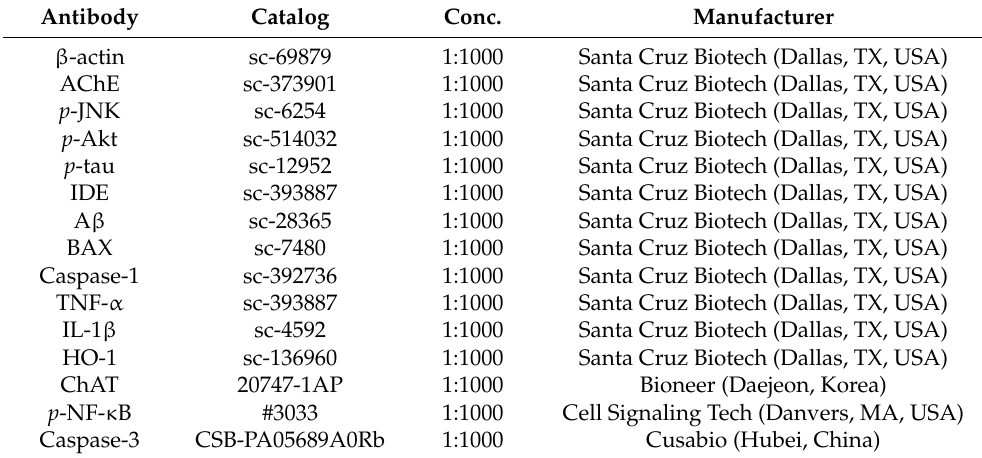
Table 1. List of primary antibody information used in this